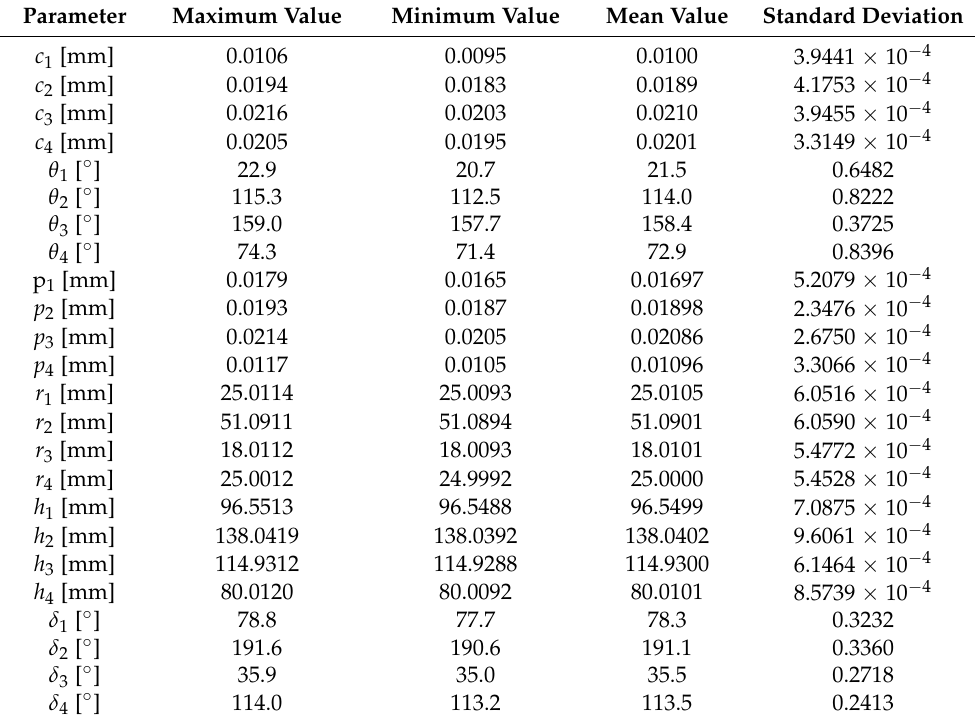
Table 4. The measured geometric parameters of the high-pressure rotor system.